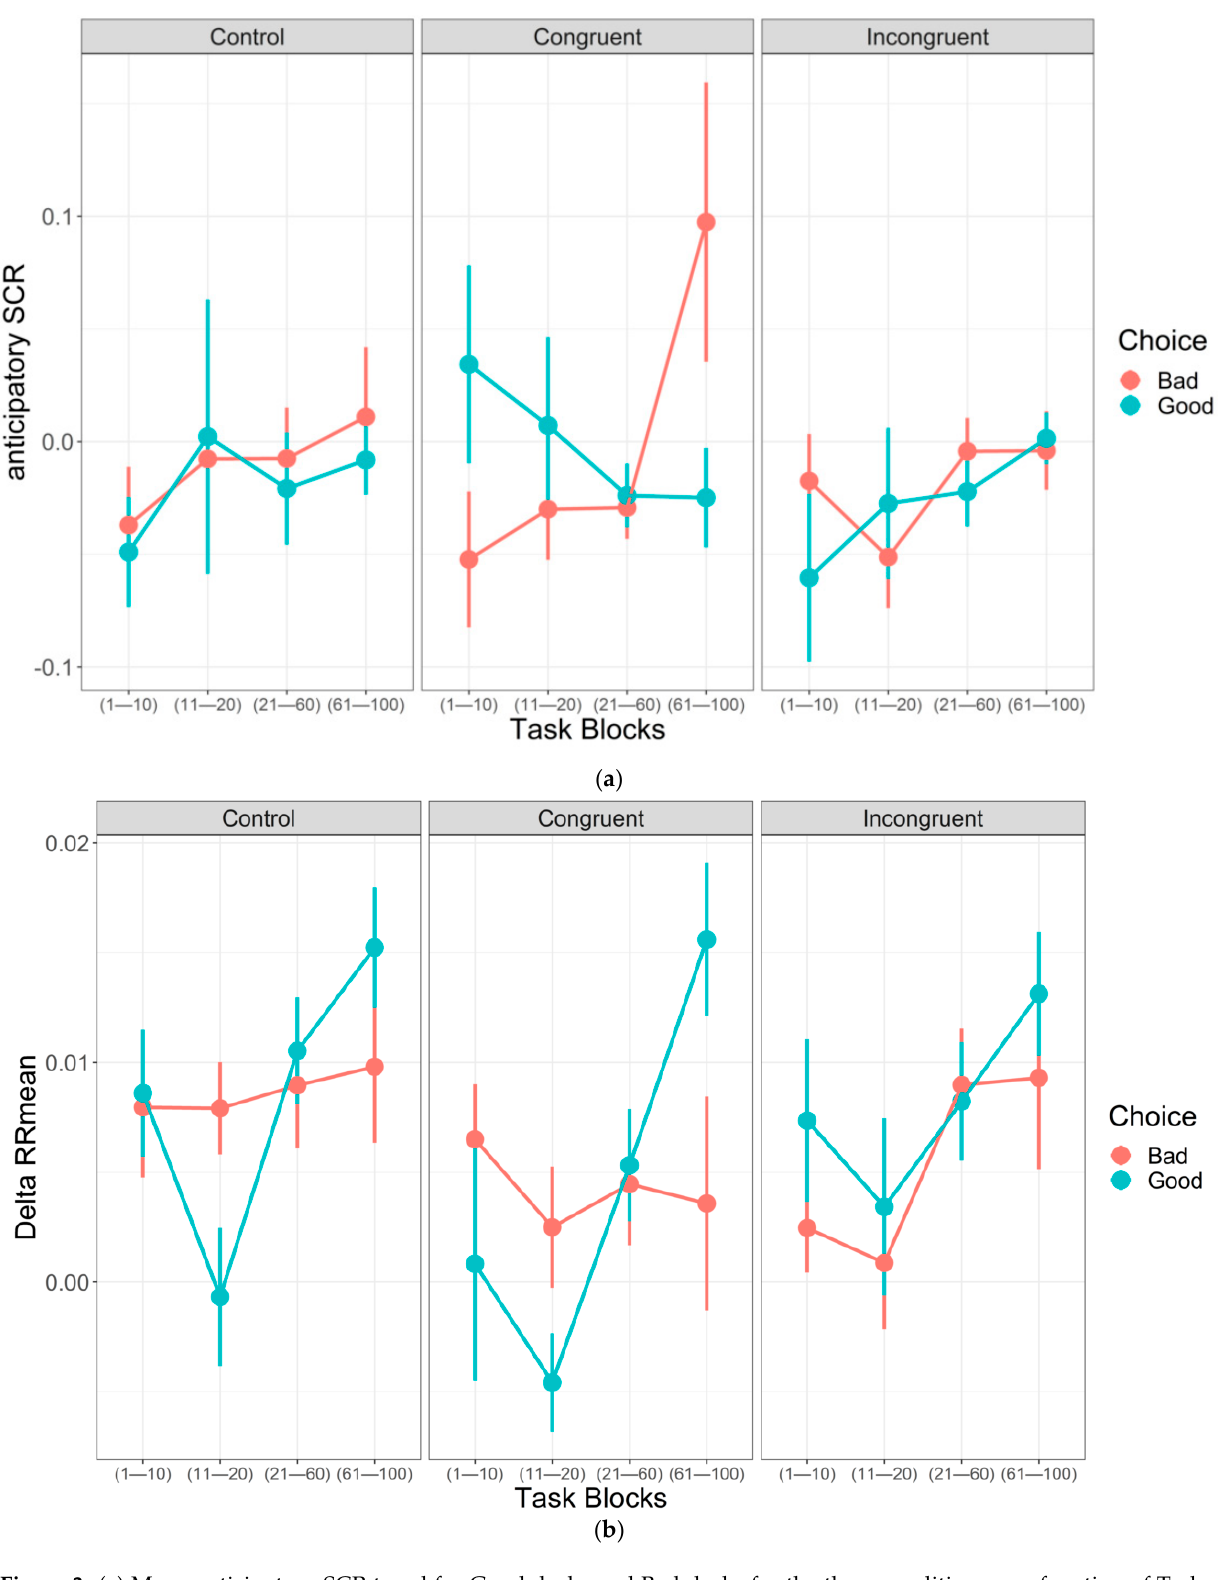
Figure 3. (a) Mean anticipatory SCR trend for Good decks and Bad decks for the three conditions as a function of Task Block; (b) DeltaRRmean trend for Good decks and Bad decks for the three conditions as a function of Task Block. Error bars represent Standard Error.